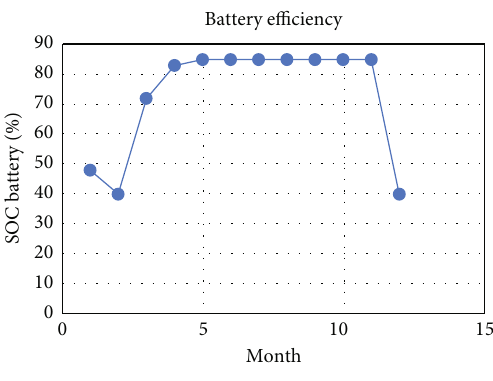
Figure 9: Block of battery SOC.